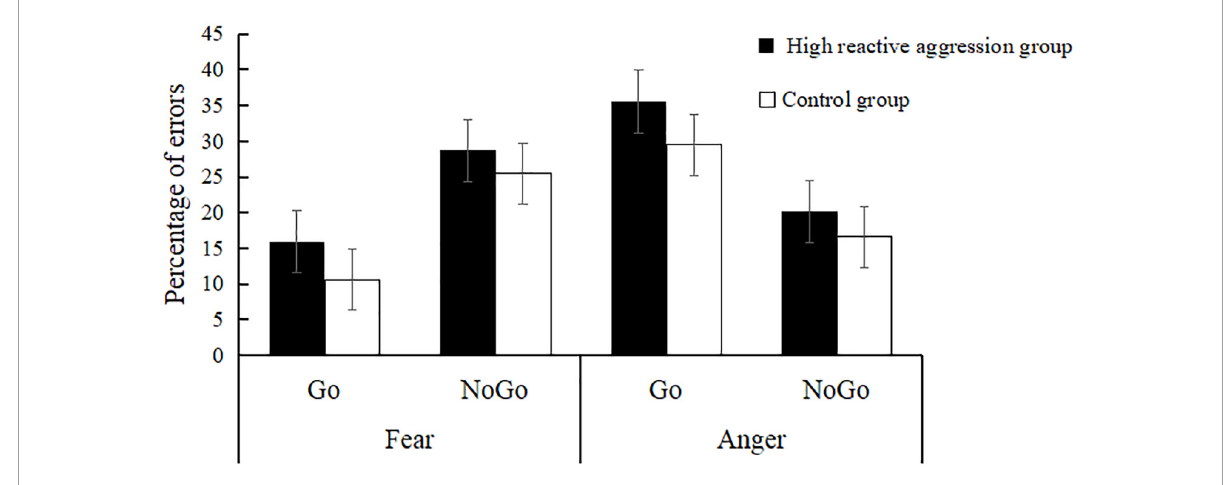
FIGURE2 Error rates during the emotional Go/No-Go task by group.